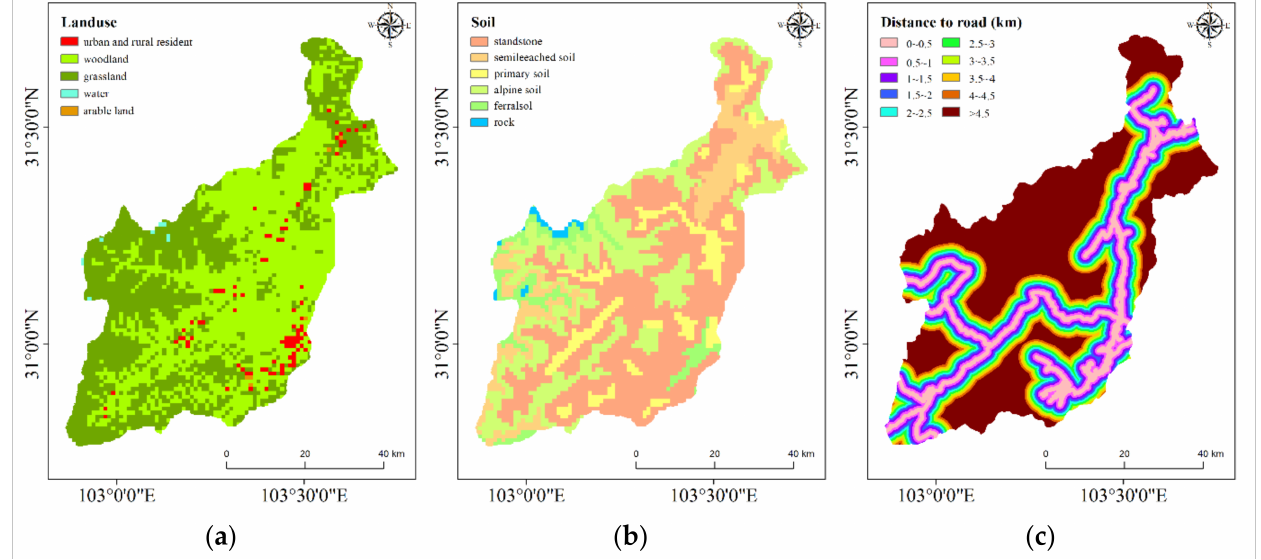
Figure 5. Land-cover-related causative factors. ( a ) Land use; ( b ) Soil; ( c ) Distance to